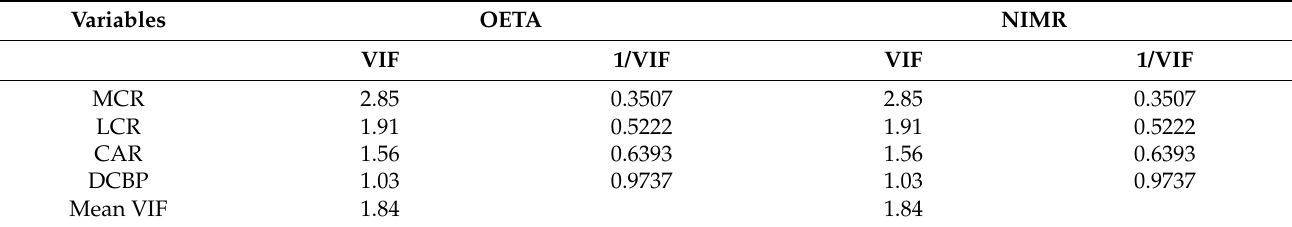
Table 3. Multicollinearity test results for the Z-score